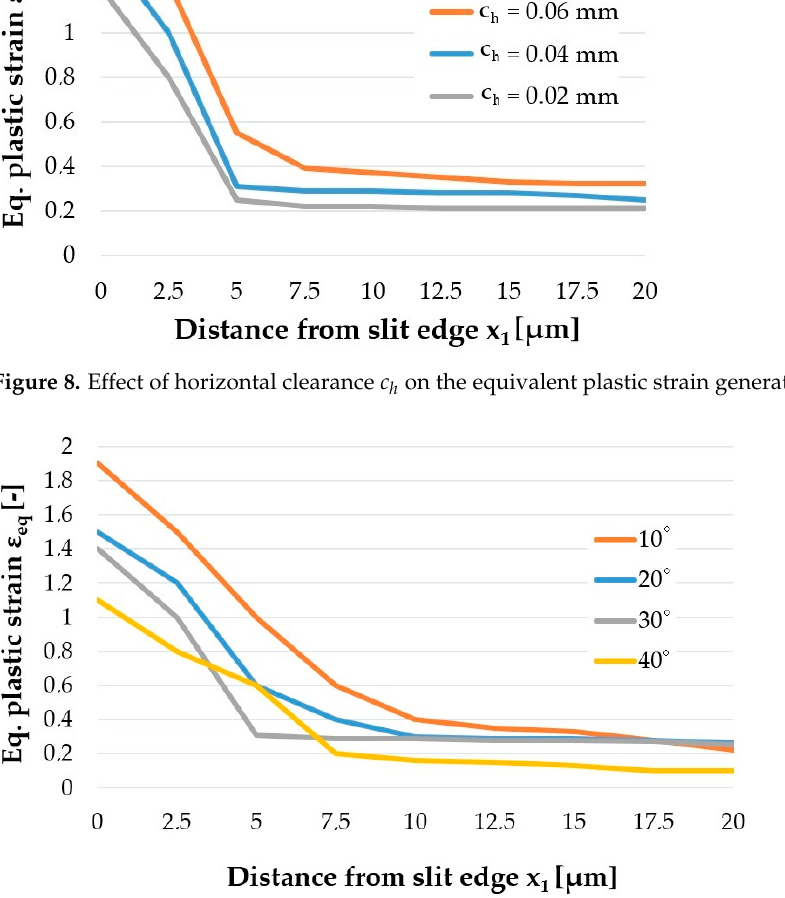
Figure 9. Effect of upper knife rake angle α on the equivalent plastic strain generated on cut edge.